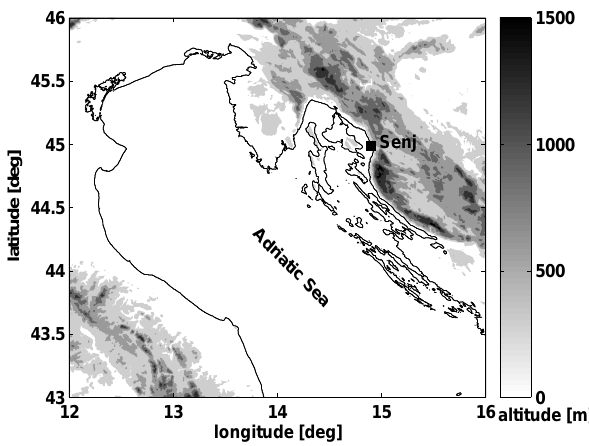
Fig. 1. The position of the town of Senj (indicated by black square) where the 4Hz bora wind measurements were performed. The ter- rain height is given every